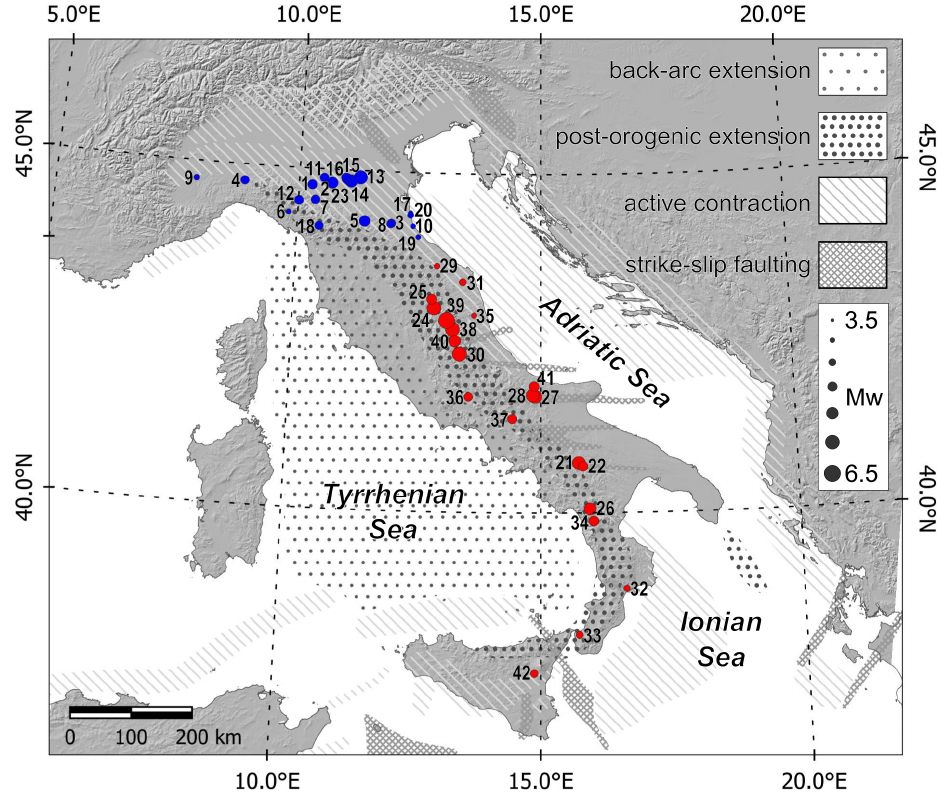
Figure 1. Location of the 42 earthquakes of the learning set used in this work and regional-scale tectonic information from the DISS database (DISS Working Group, 2021). The areas with different patterns indicate active tectonic domains that exist in the Italian Peninsula and surrounding areas (from Vannoli et al., 2021). The learning set includes earthquakes that occurred in northern Italy, shown in blue (Table 1, IDs 1 to 20 and 23), and in central and southern Italy, shown in red (Table 1, IDs 21 to 42, except for